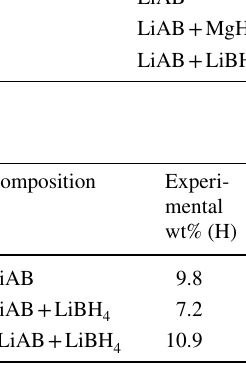
Table 3 The first dehydrogenation temperature (A process) of the three different LiNH 2 BH 3 composites (TPD with heating rate 1 °C min −1 under 1 bar H 2 pressure) First dehydrogenation temperature (°C)